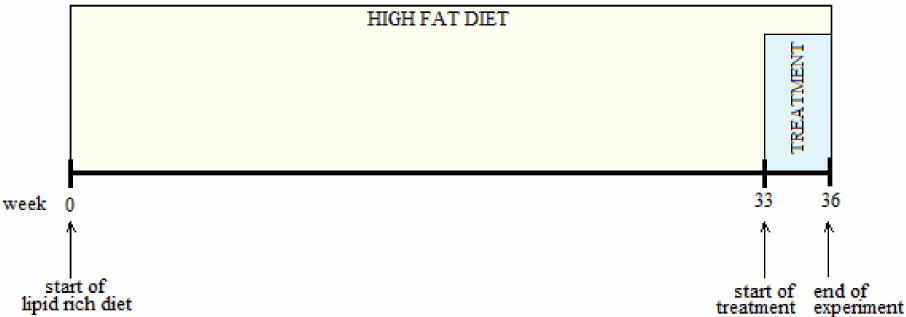
Figure 1. The time course of scheduled experiment to treat overweight rats after 32 weeks of HFD: at the beginning of the 33rd week with high-fat diet, the rats received by oral gavage and for another 4 weeks with HFD: normal saline 0.9% (HFD group), Cornus mas L. extract solution (HFD + CM group) or gold nanoparticles functionalized with bioactive compounds from Cornus mas L. extract (HFD + AuNPsCM group). The Control group received standard diet and, in the last month of the experiment, normal saline 0.9% by oral